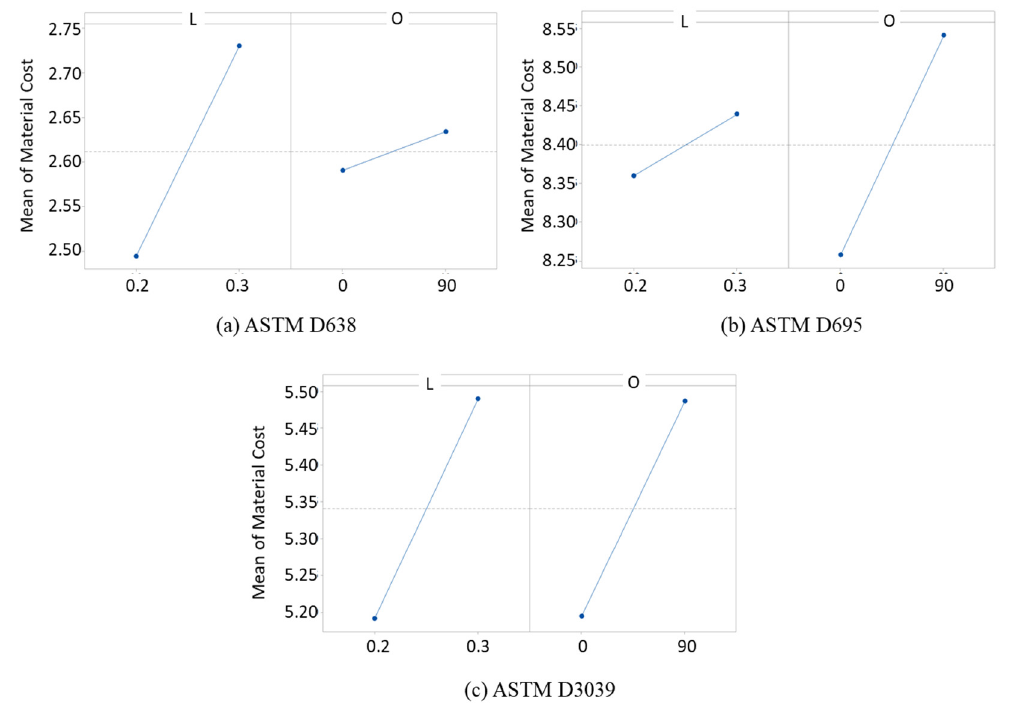
Figure 10. Main effect plots of the significant factors for material cost. ( a ) ASTM D638; ( b ) ASTM D695; ( c ) ASTM D3039.